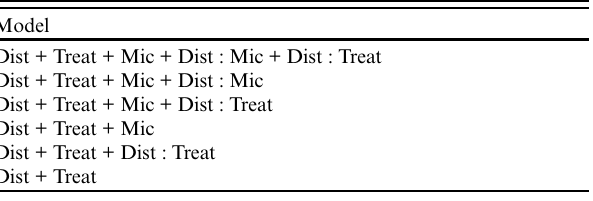
Table 1 . Candidate set of models used in analyses including distance to the sound source (Dist), noise treatment (Treat), microphone sensitivity loss (Mic), and relevant interactions among